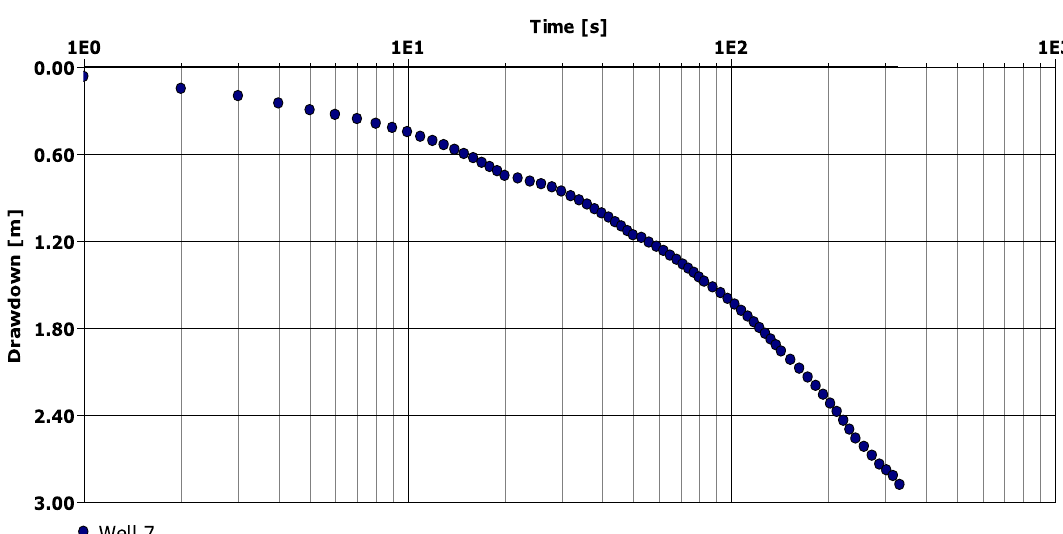
Fig. 23 Theis’s method of pumping well-6